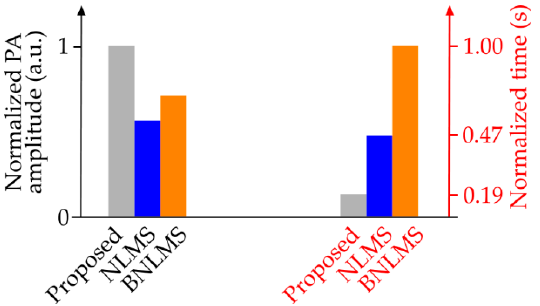
Figure 6. Performance comparison between normalized least mean square (NLMS), block normalized least mean square (BNLMS) filtering, and proposed methods in terms of signal amplitude enhancement and computational complexity. Table 1. Comparison between averaging and the proposed method for different numbers of acquisitions.